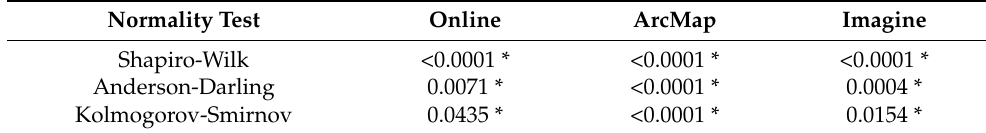
Table 2. Normality Test Results for Each Set of RMSE (* denotes significant at the 0.05 level). Normality Test Online ArcMap Imagine Shapiro-Wilk <0.0001 * <0.0001